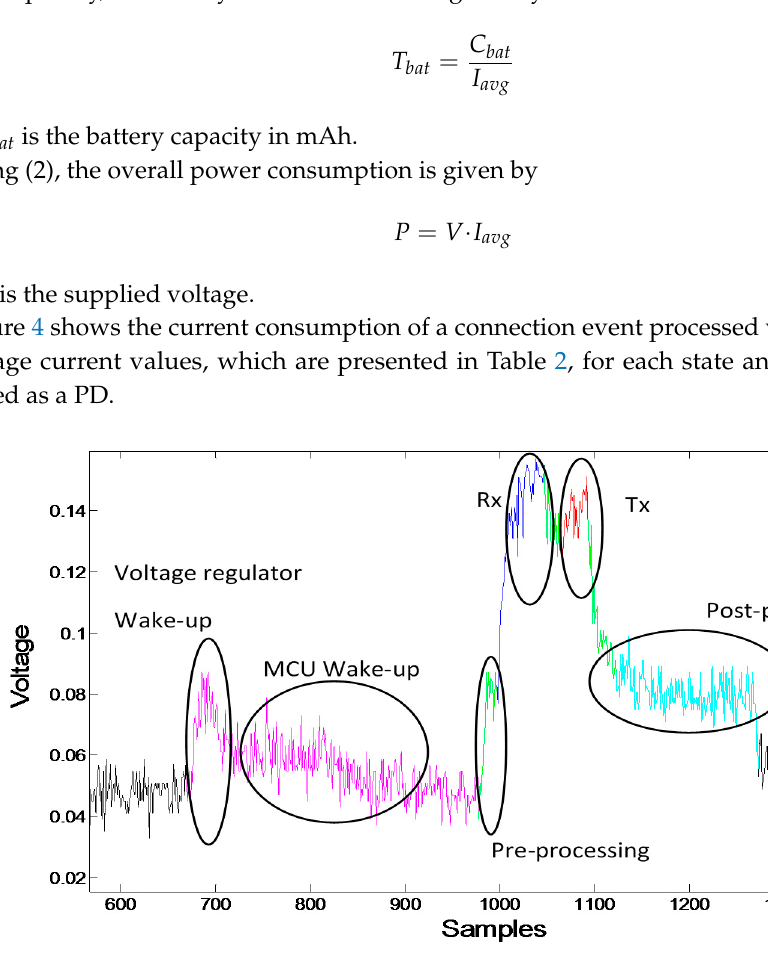
Figure 4. Matlab waveform of a peripheral connection event. Table 2. Current consumption comparison between the platforms configured as a PD using a connection interval of 100 ms.